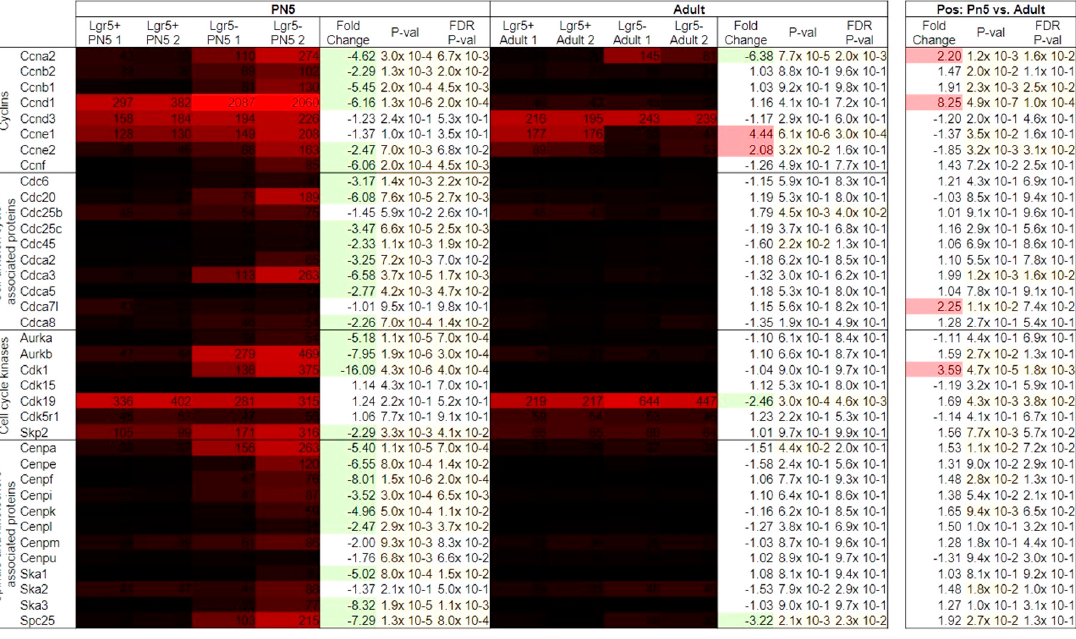
Figure 2. Gene expression levels and fold changes of cell cycle markers. Fold change describes downregulated cell cycle genes at PN5 in Lgr5 + cells compared to Lgr5 − cells. Di ff erentially expressed genes were defined by a fold change ≥ 2 or ≤ − 2, p -value < 0.05, and false discovery rate (FDR) < 0.05.